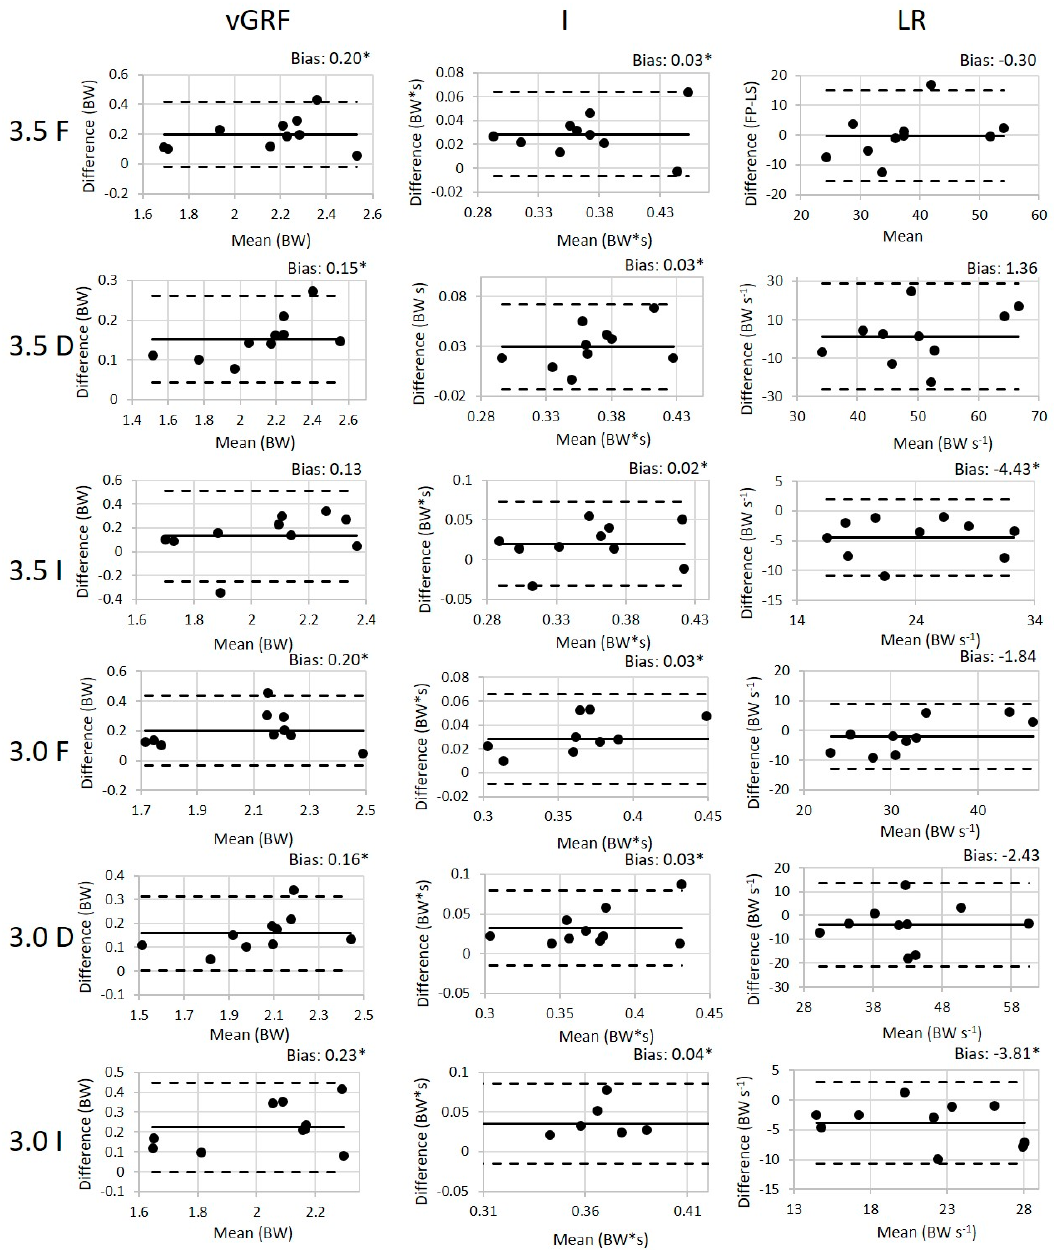
Figure 5. The Bland–Altman plots for the running conditions with the 200 Hz loadsol ® for both running speeds (3.0 and 3.5 m/s) flat (F), inclined (I), and declined (D). The difference is calculated by subtracting the loadsol ® values from the force plate values. The bias is displayed for each variable with a * indicating a statistically significant difference between the force plate and loadsol ® .